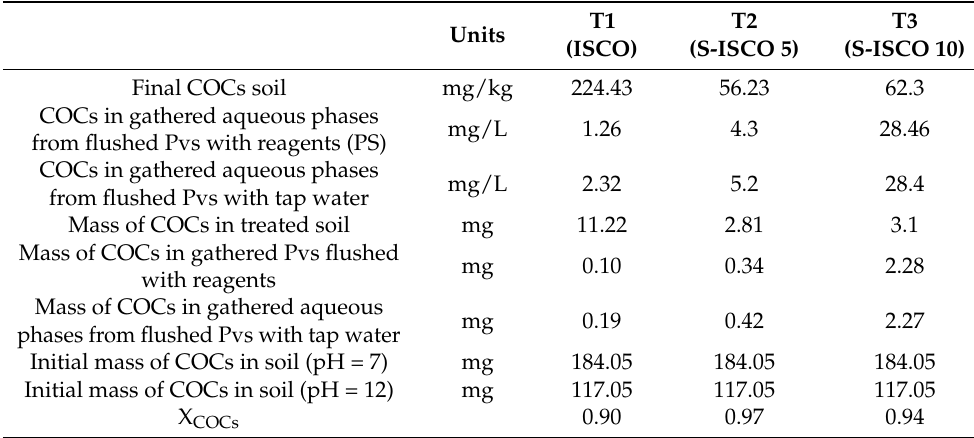
Table 4. Mass balance of COCs in T1, T2, and T3